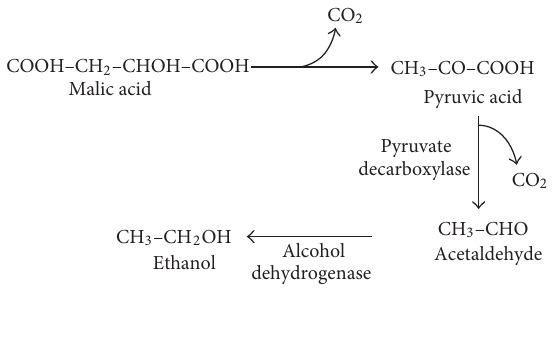
malvidin-3-glucoside (peak 6), peak 4 was identi�ed as pelargonidin-3-glucoside, whose structure is shown in Figure 2. e MS analysis of pelargonidin-3-glucoside produced a [M ] peak at m/z 433 and a fragment at m/z +